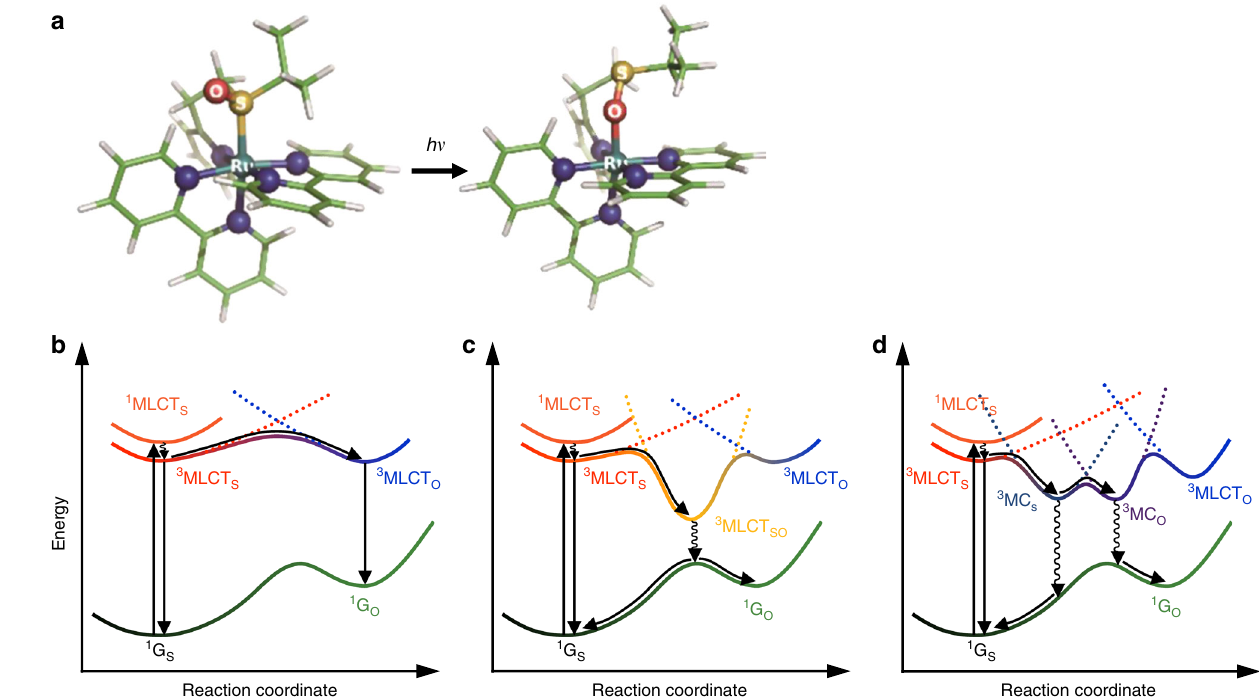
Fig. 1 Structures of [Ru(bpy) 2 (pyESO)] 2 + and various photoisomerization pathways. a Molecular structures before and after photoinduced isomerization. Color code: cyan Ru, yellow S, red O, blue N, green C, white H. b Adiabatic photo-isomerization on lowest 3 MLCT excited states. c Non-adiabatic photo- isomerization on lowest 3 MLCT excited states. d Non-adiabatic photo-isomerization involving 3 MLCT and 3 MC excited states. Vertical arrows represent photo-absorption and emission processes. Wavy arrows represent non-radiative transitions (conical intersections are not shown for simplicity). Curvy arrows represent adiabatic relaxation paths on potential energy surfaces. Dotted lines represent diabatic states for triplet states. 1 G S : S-bonded ground state reactant, 1 G O : O-bonded ground state photoproduct, 3 MLCT S : S-bonded 3 MLCT excited state, 3 MLCT O : O-bonded 3 MLCT excited state, 3 MLCT SO : sideways SO-bonded 3 MLCT excited state, 3 MC S : S-bonded 3 MC excited state, 3 MC O : O-bonded 3 MC excited